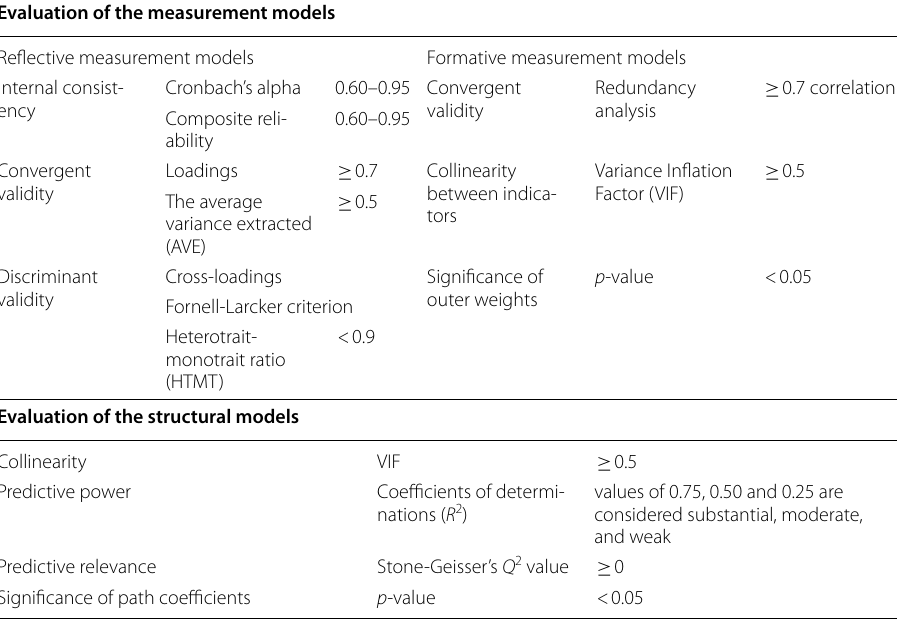
Table 2 Evaluation of PLS-SEM models Evaluation of the measurement models Reflective measurement